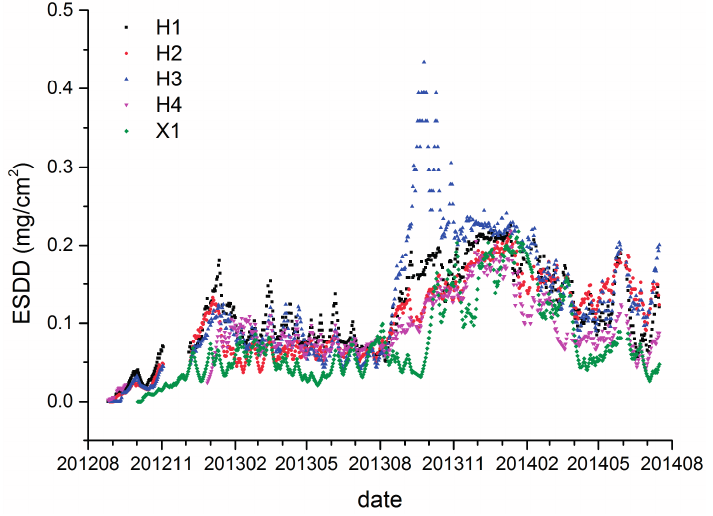
Figure 7. On-line measurements of five sites in Huangshi and